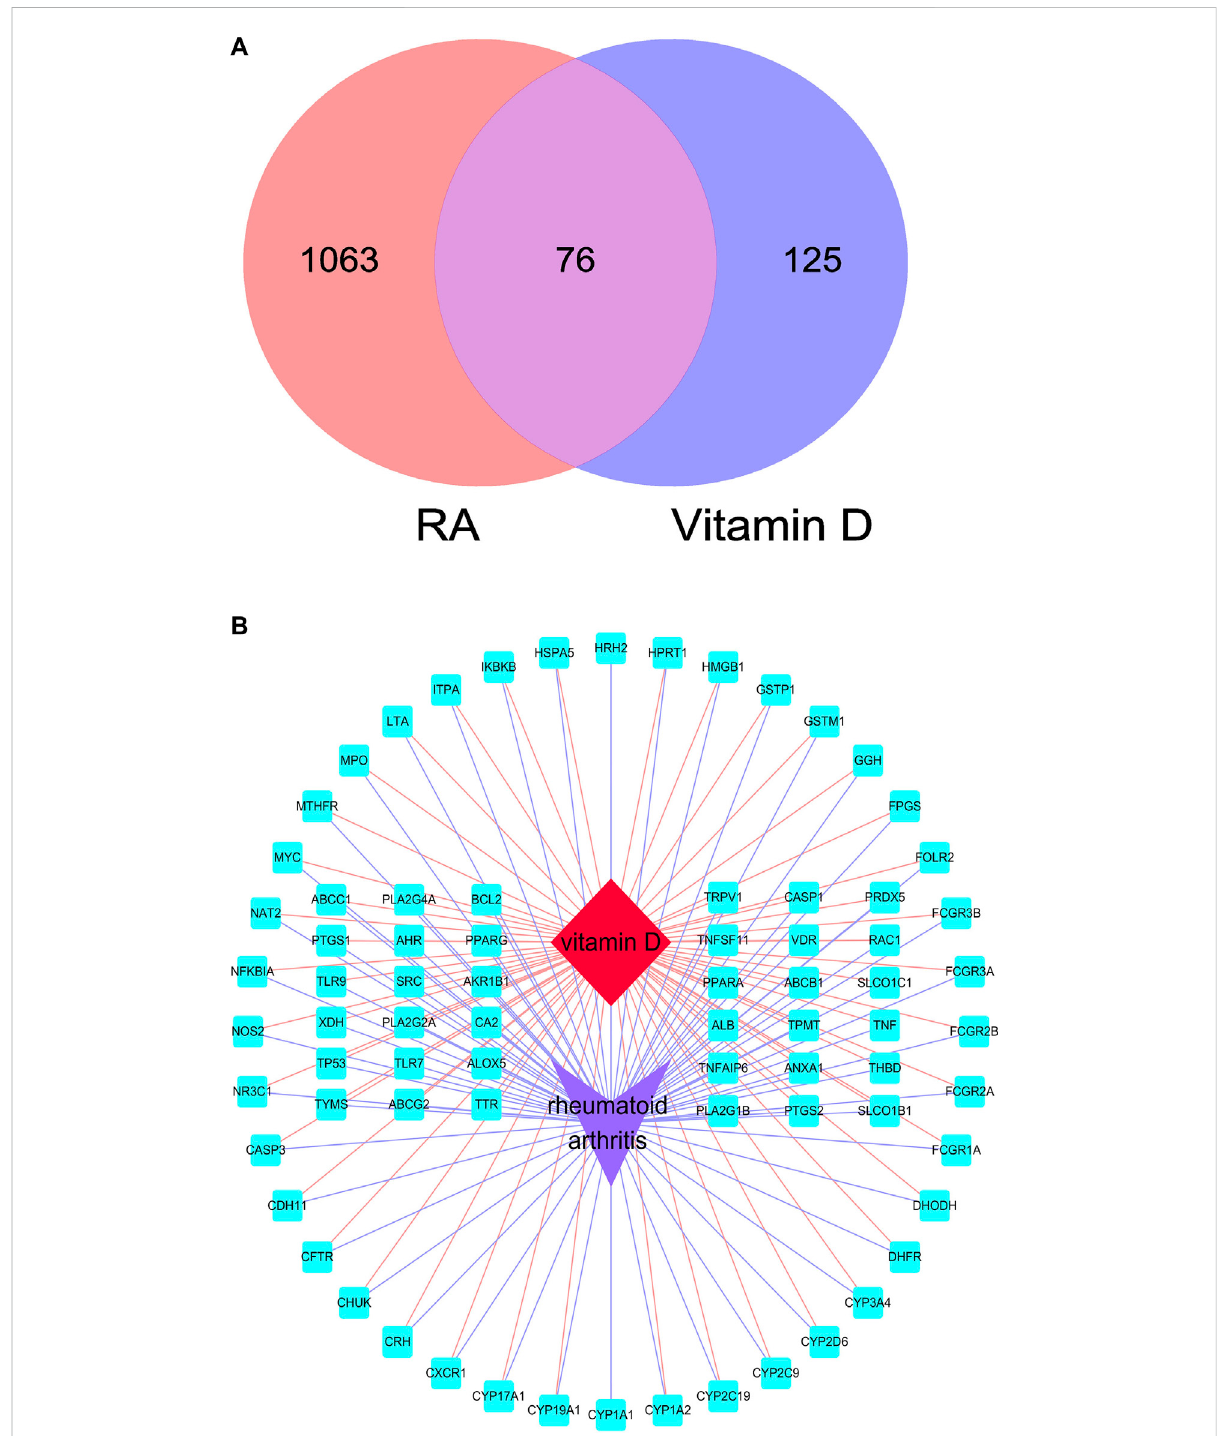
FIGURE 2 Overlapping targets of RA and vitamin D. (A) Overlapping targets identi fi ed by Venny. (B) “ vitamin D – overlapping genes – RA ” network map. The red diamond represents RA, the purple arrow represents vitamin D, and the blue square represents overlapping